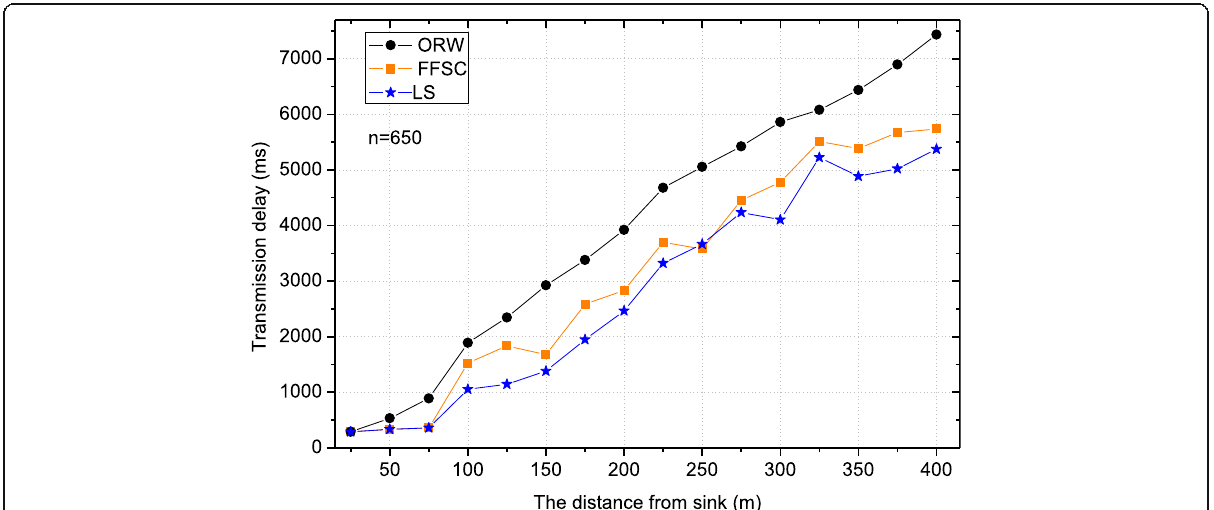
Fig. 22 The total delay under different distance from